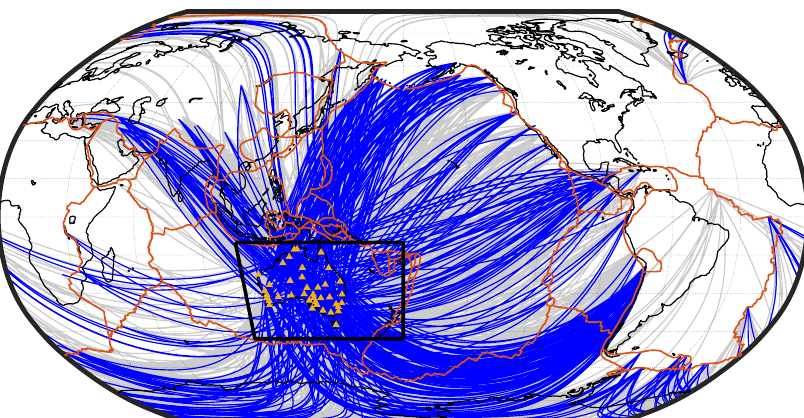
Fig. 2 Global distribution of source-receiver paths analyzed for QL waves. Great-circle paths on which QL waves were present are shown in blue, the remainder in grey. The location of anisotropic gradients within the area of interest (black box, Fig. 3) is investigated using 43 seismic receivers (yellow triangles) based within Australia. Plate boundaries (in orange) from ref.